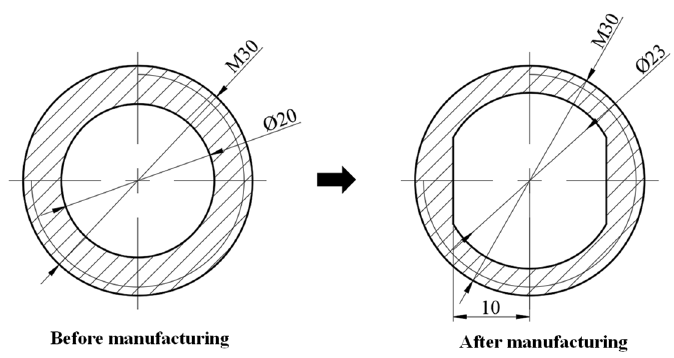
Figure 20. The cross-section of the threaded connection.